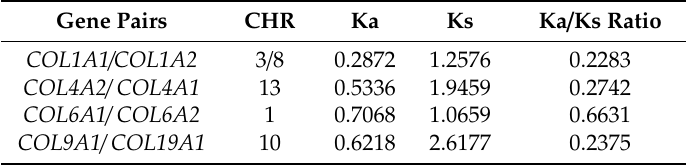
Table 2. Analysis of the Ka/Ks ratios for each pair of duplicated collagen genes in buffalo. Gene Gene Pairs